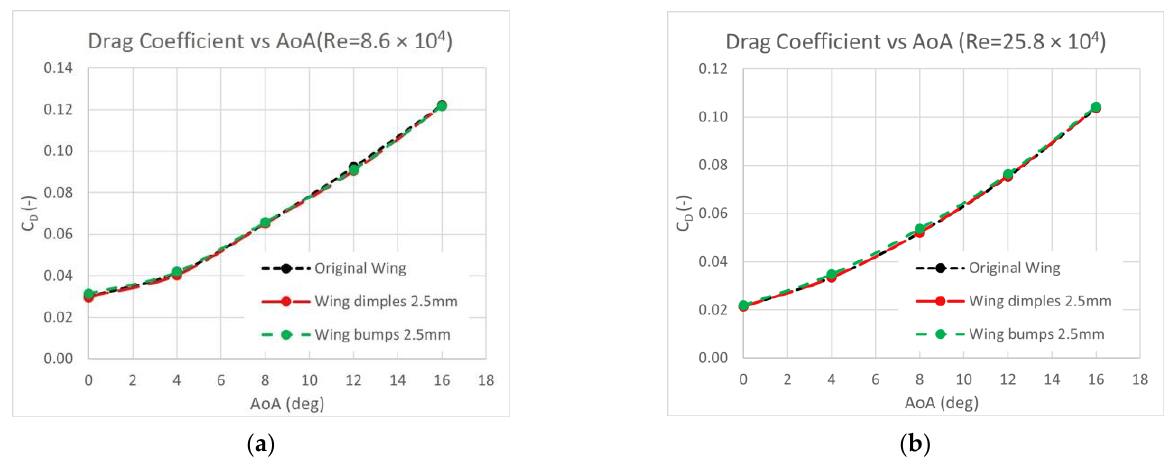
Figure 10. Drag coefficient of the three wings under ( a ) Re = 86,000 and ( b ) Re = 258,000.